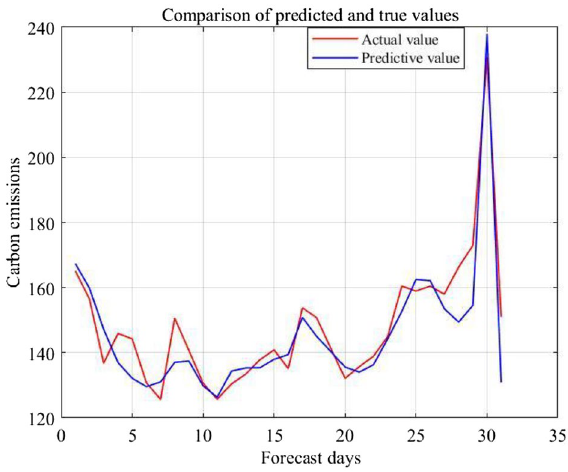
Figure 7. Carbon emission forecast and actual values for January 2022.